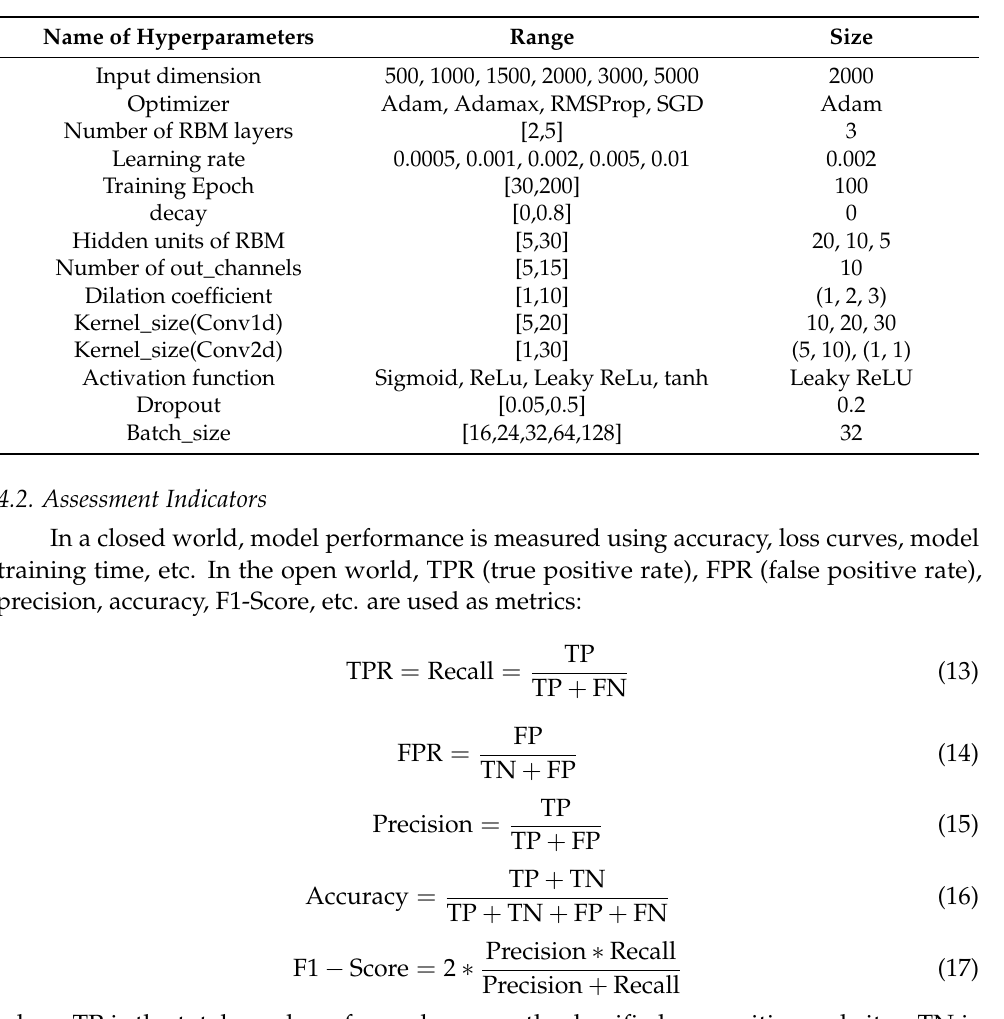
Table 3. Hyperparameters